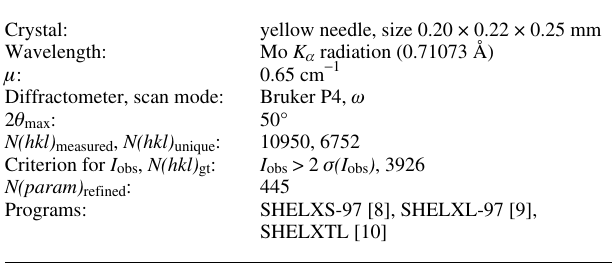
Table 1. Data collection and handling.